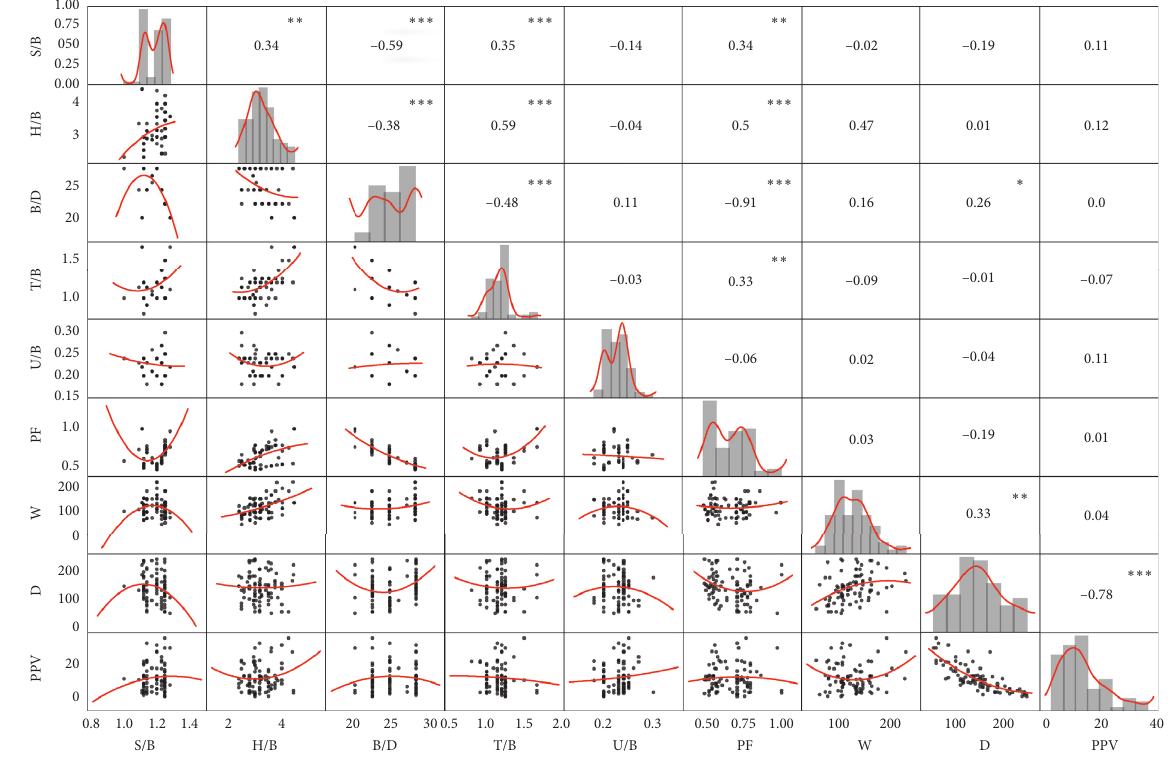
Figure 1: Scatter plot of the established